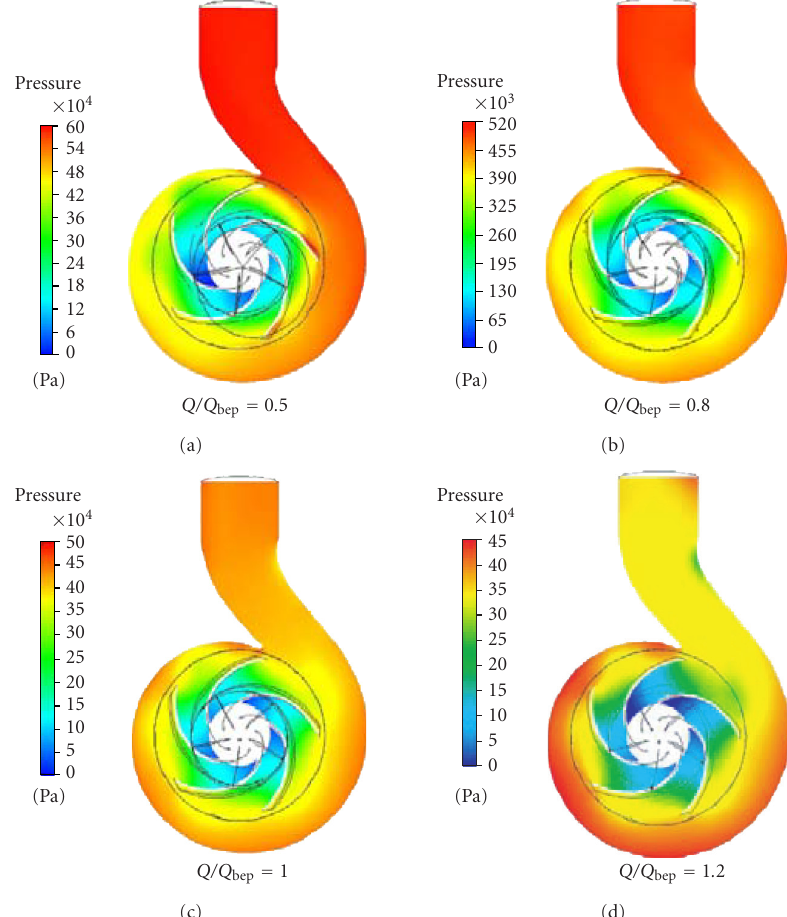
Figure 19: Pressure field at di ff erent pump capacities.